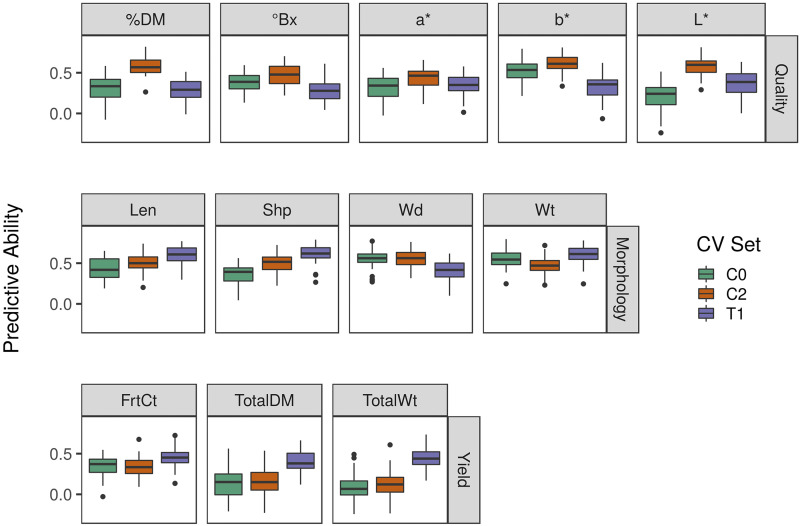
Cross-validation results. Boxplots show the predictive ability for each trait grouped by cross-validation set and trait type. Cross-validation was conducted within the base population (CVC0), the C2 population (CVC2), and in the test population (CVT1).